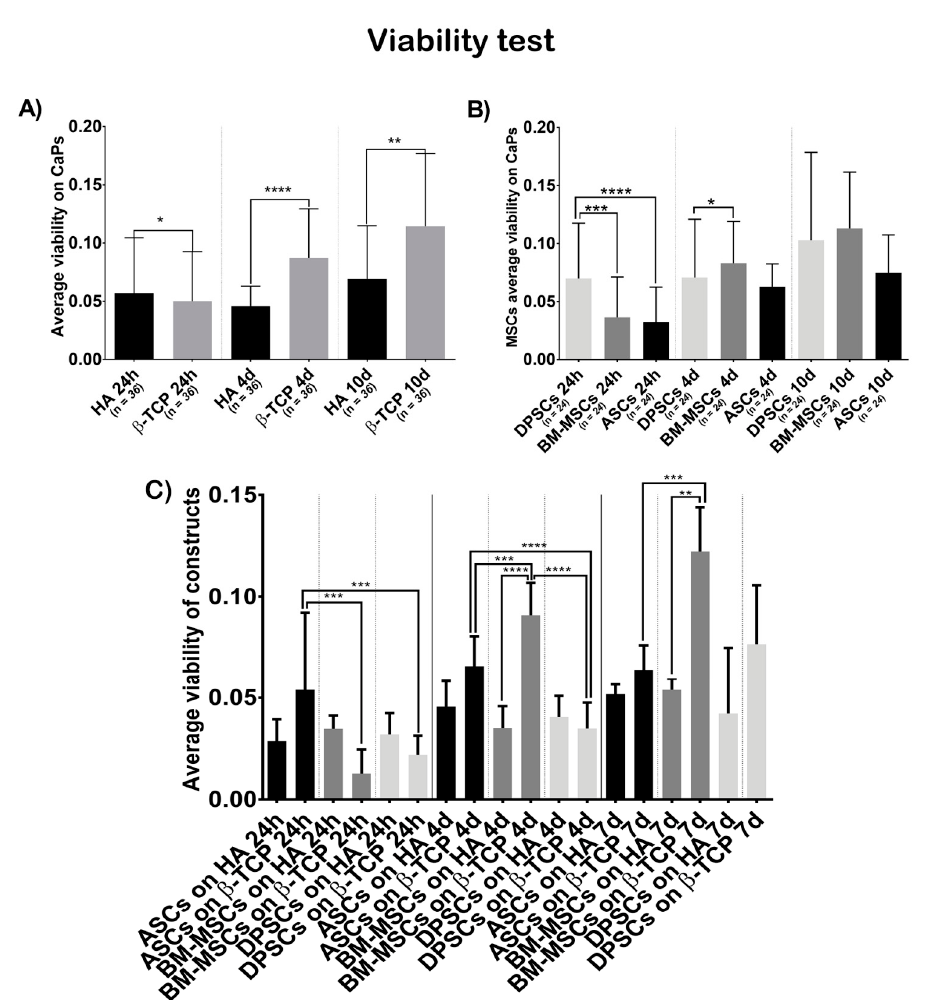
Figure 2. Cell viability, in terms of optical density at 570 nm, when seeded on CaPs: ( A ) average viability shown by all MSCs on each CaP—Hydroxyapatite (HA) and ß-tricalcium phosphate ( β -TCP); ( B ) average viability shown by each MSC on both CaPs—Adipose tissue (ASCs), dental pulp (DPSCs), and bone marrow (BM-MSCs); ( C ) average viability shown by each construct. All data are shown as mean ± standard deviation. Significance level: * p ≤ 0.05, ** p ≤ 0.01, *** p ≤ 0.001, **** p ≤ 0.0001.